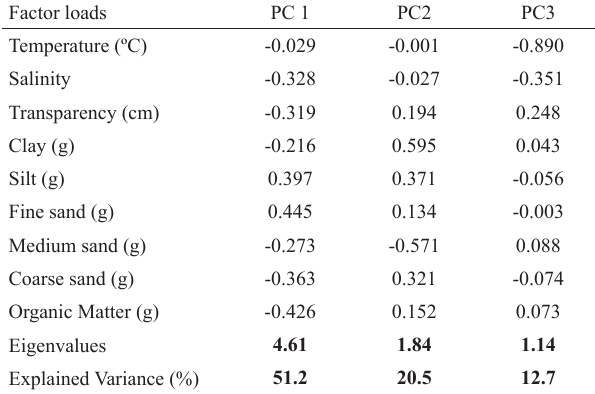
Table 3. Factors loads from principal component analysis on environmental parameters from rio Mamanguape estuary, northeastern Brazil.